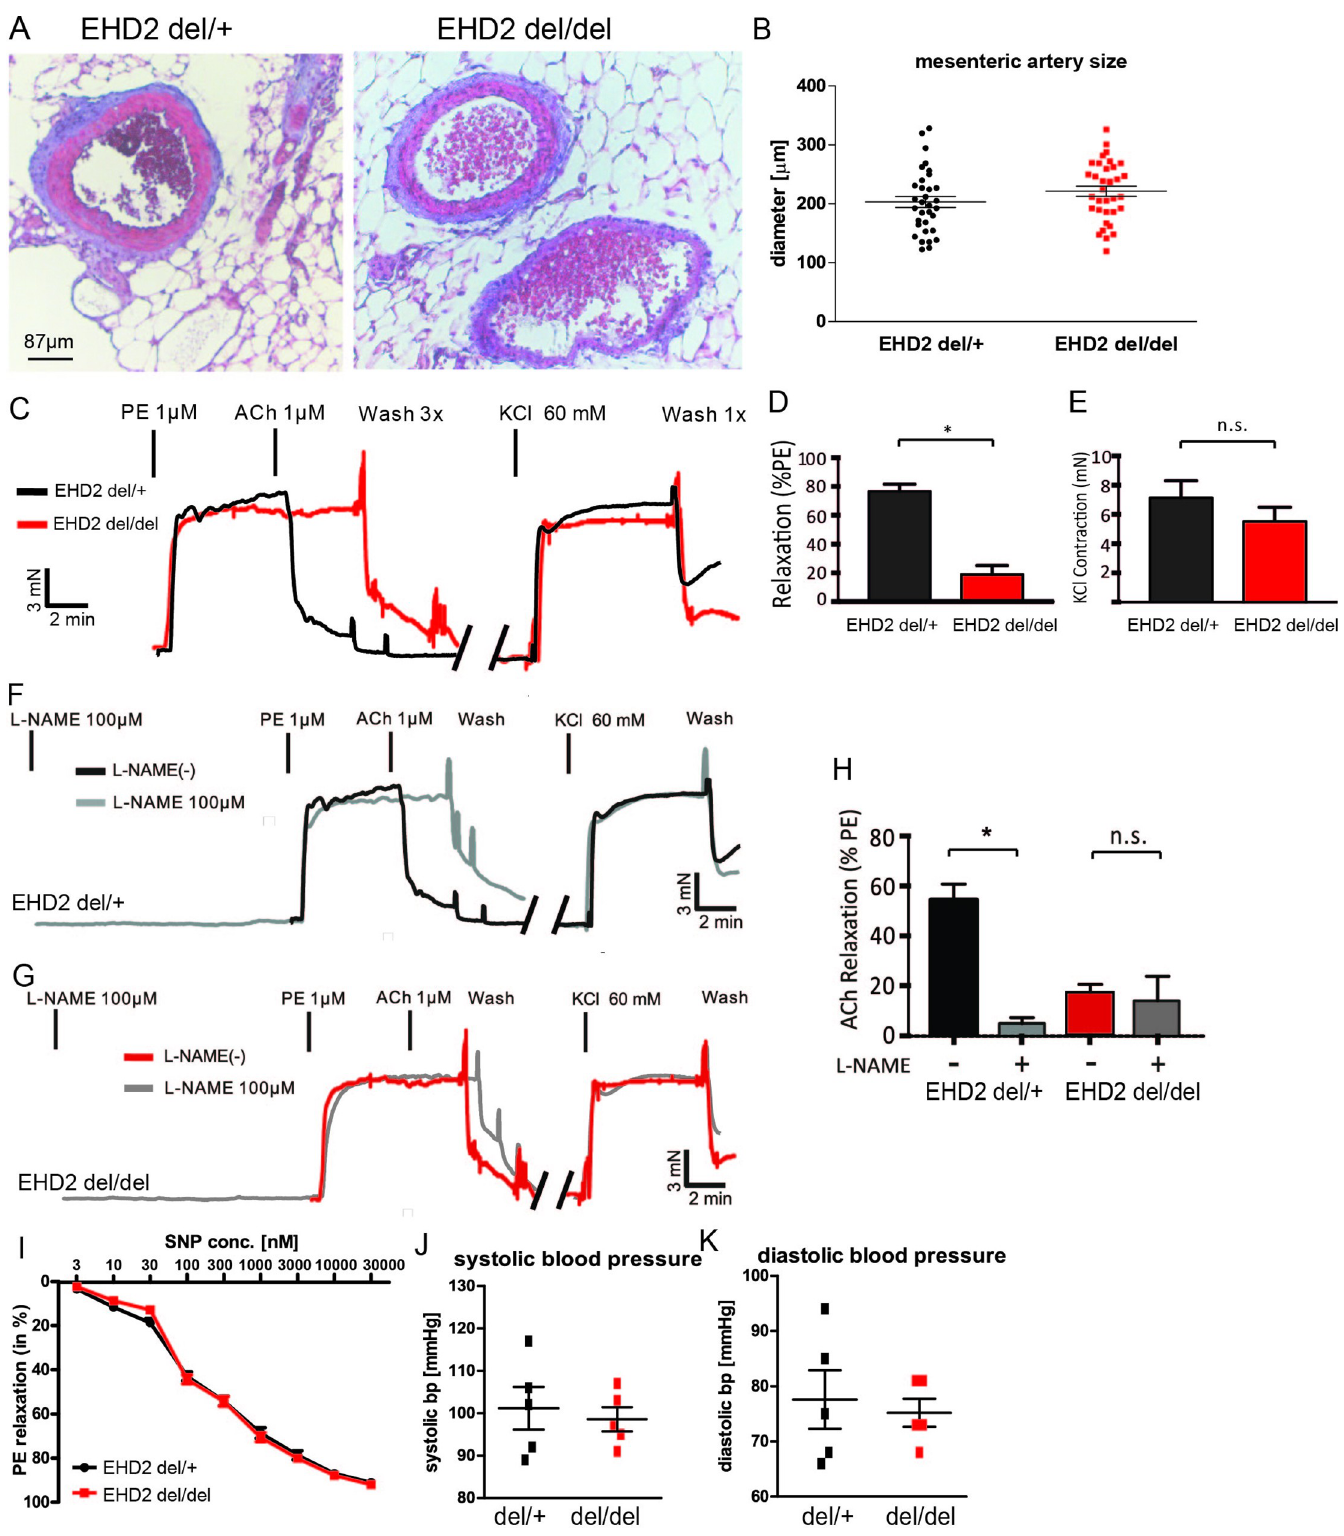
Fig 2. Loss of EHD2 results in impaired relaxation of mesenteric arteries. (A) Representative histological staining of EHD2 del/+ and del/del mesenteric arteries revealed no severe morphological differences. (B) Summary of mesenteric artery diameter in EHD2 del/+ and del/del mice (n(del/+) = 33; n(del/del) = 35). (C) Example